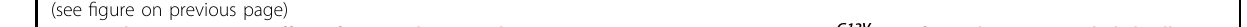
Fig. 1 Selective cytotoxic effect of BSO and DPI combinatory treatment on oncogenic HRAS G12V -transformed ovarian epithelial cells. A – C qRT-PCR analysis of the expression levels of GCLC , GCLM , and GSS genes in T72 and T72Ras cells. β -actin serves as a control. D Western blot analysis of p22phox, GCLC, and GR protein levels in T72 and T72Ras cells. β -actin serves as a loading control. E – F Quantitative analysis of GCLC and GR protein levels in D . G T72 parental cells and their isogenic HRAS G12V -transformed T72Ras cancer cells were treated with glutathione biosynthesis inhibitor BSO at 0, 10, 30, or 100 μ M for 30 h. Cell viability was measured by fl ow cytometry with annexin-V/PI double staining. The numbers shown at the upper left of each panel indicate the percentage of the annexin-V/PI positive cells. H T72 and T72Ras cells were treated with DPI at 1 or 3 μ M for 30 h. Cell viability was measured as described in G , and cell death was expressed as the percentage of the annexin-V/PI positive cells. I Combined treatment using BSO (10, 30, or 100 μ M) and DPI (1 μ M) for 30 h induced signi fi cant death of T72Ras cells (lower panel) but not parental T72 cells (upper panel). Data are mean ± SD of three independent experiments with Student ’ s t test. ** p < 0.01, *** p < 0.001, **** p < 0.0001. KDa